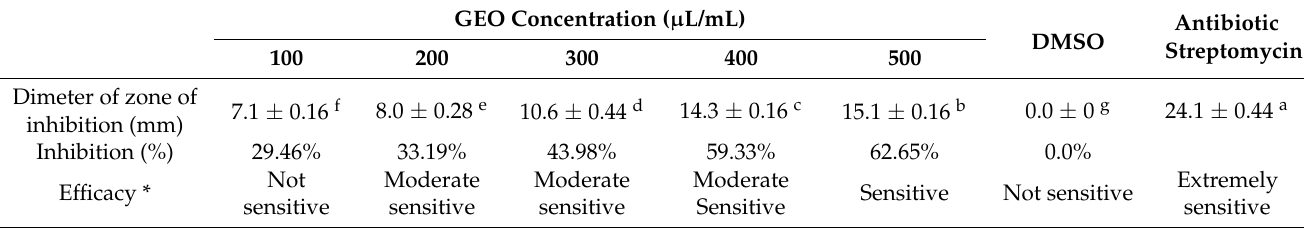
Table 3. Antibacterial activity of GEO at different concentrations and streptomycin against B. glumae using disc diffusion